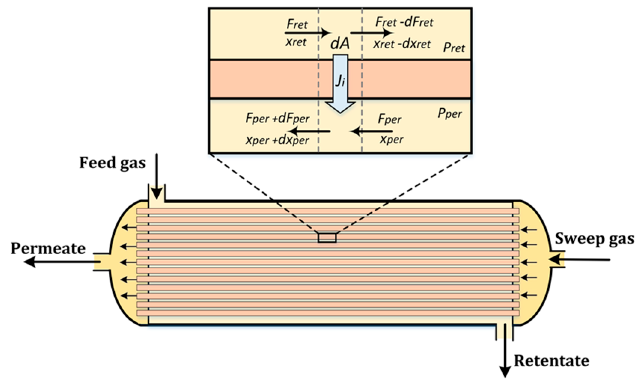
Figure 2 . Schematic diagram of a counter-current flow membrane module . Figure 2. Schematic diagram of a counter-current flow membrane